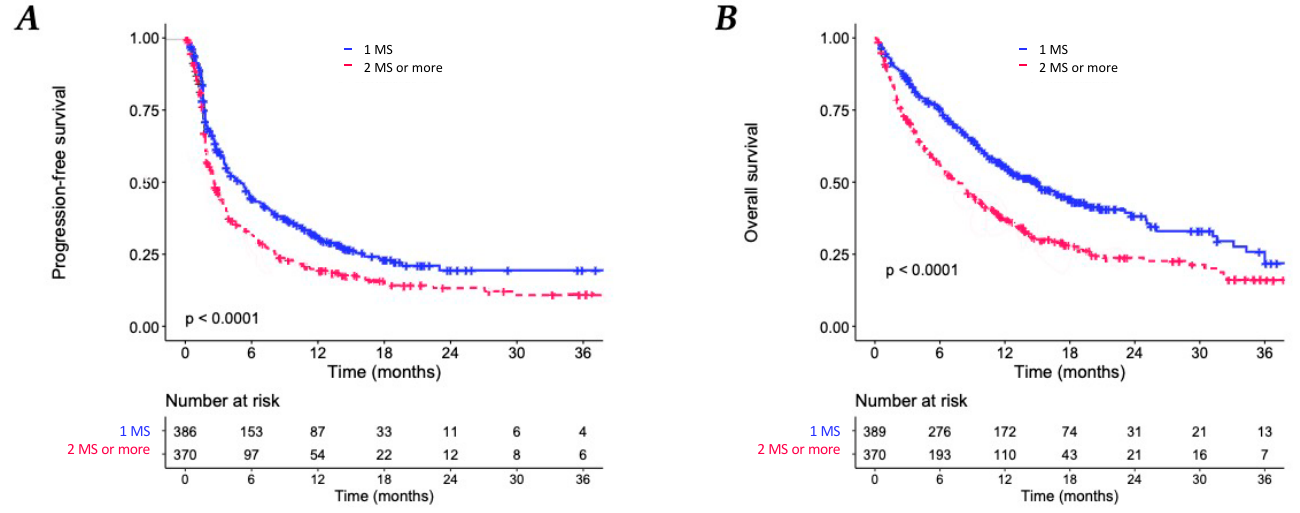
Figure 2. Kaplan–Meier analyses. ( A ) Progression-free survival (PFS) according to metastatic site (MS) number (1 MS versus ≥ 2 ML). ( B ) Overall survival according to MS number (1 MS versus ≥ 2 MS).